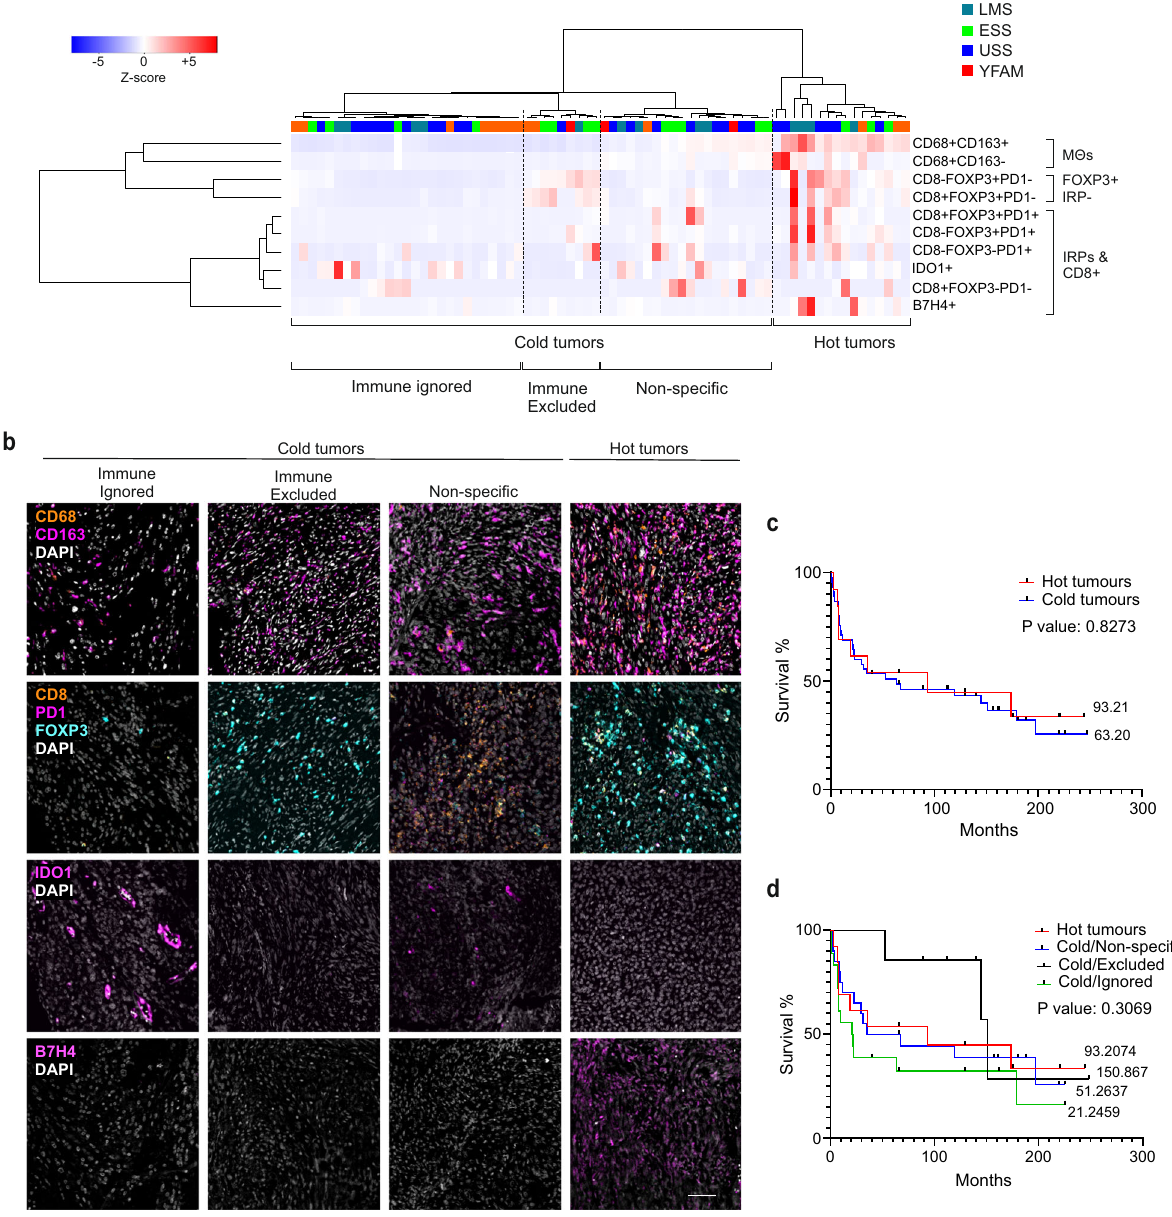
Fig. 3 Unsupervised hierarchical clustering of immune marker expression reveals four distinct immune groups independently of tumor types. a Unsupervised hierarchical clustering of mesenchymal uterine tumors based on the expression of immune markers. b IF images of tumors representing the four immune groups represented in the unsupervised hierarchical clustering. Scale bar indicates 100 μ m. c Kaplan – Meier curves of patients with hot and cold tumors de fi ned in ( a ). d Kaplan – Meier curves of patients grouped based on the four distinct immune groups de fi ned in ( a